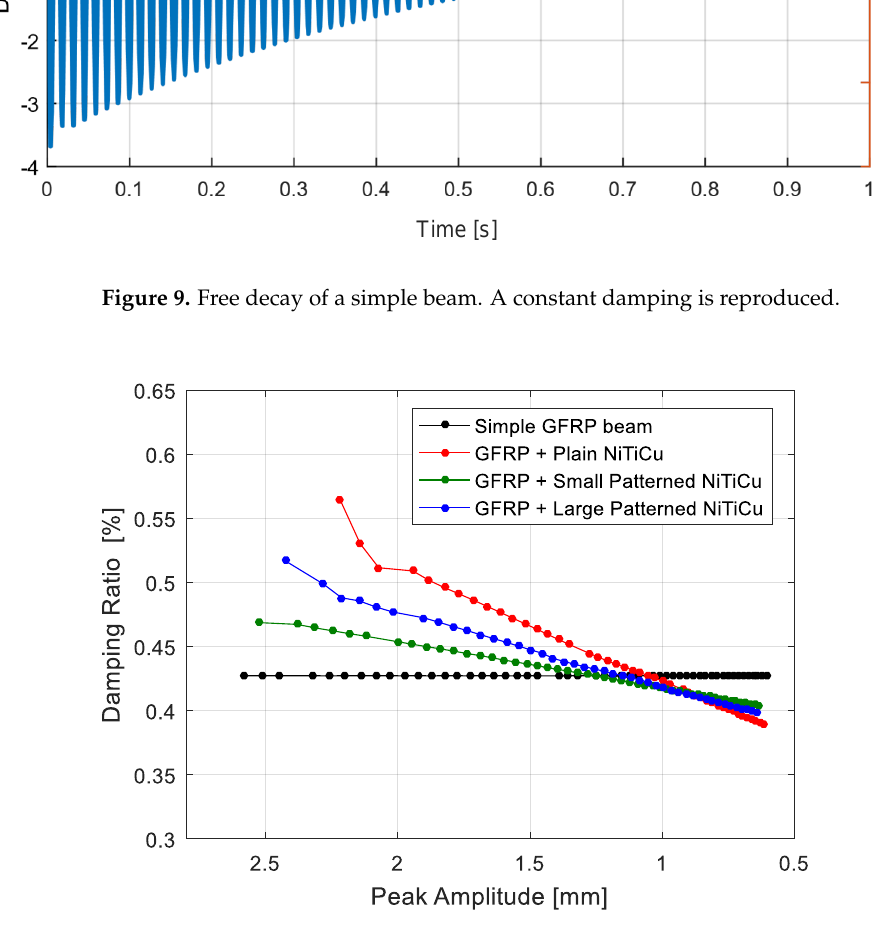
Figure 10. Comparison of the damping ratio as function of displacement for each architecture of Ni 40 Ti 50 Cu 10 hybrid